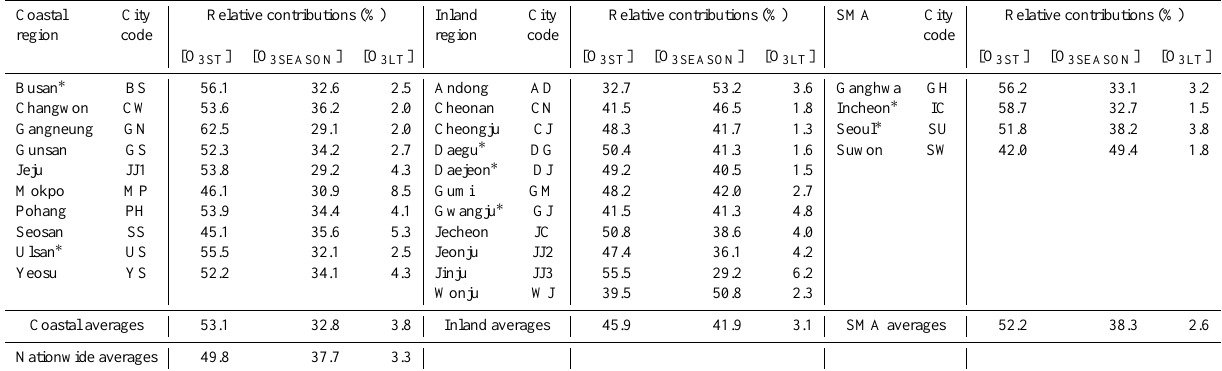
Coastal averages 53.1 32.8 Inland averages Nationwide averages